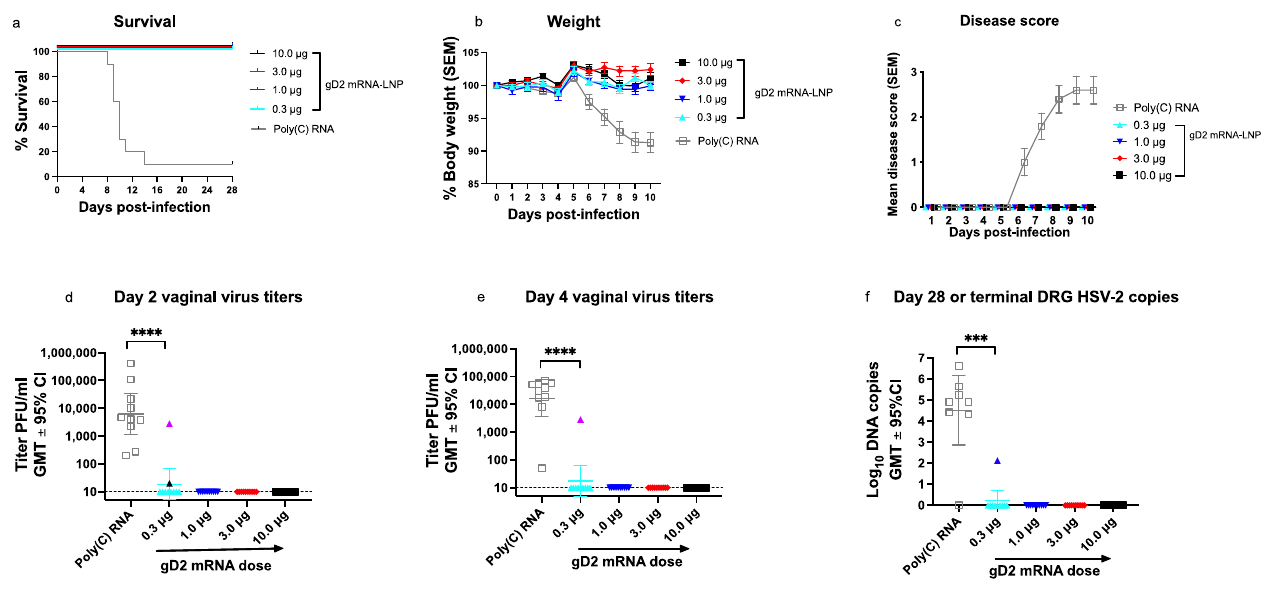
Figure 4. Combined responses to all six epitopes. The antibody titers to all six crucial gD2 epitopes at each immunization dose are displayed on a single graph. p values were calculated by ordinary one-way ANOVA with Sidak’s correction for multiple comparisons; n = 30 data points at each gD2 dose based on antibody responses to 6 epitopes x 5 sera; ** p < 0.01; ns, not significant.